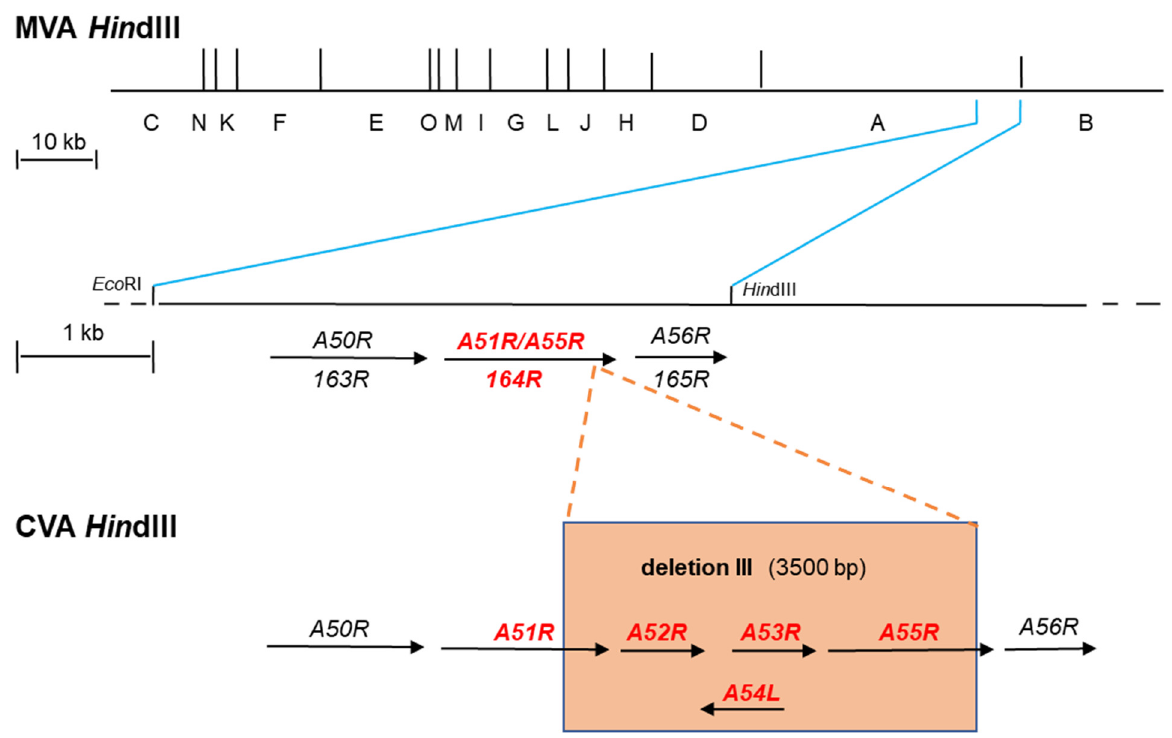
Figure 1. Illustration of the MVA genome and comparison of two distinct gene nomenclature systems which are currently applied. The VACV strain Copenhagen nomenclature relies on digestion of the viral genome using the restriction enzyme Hi ndIII. In the resulting Hind III map, the fragments obtained are alphabetically labeled from A to O. The largest fragment is named A and the smallest as O. Since the genome is bidirectional, genes are labeled R (right) and L (left) to indicate the genomic orientation of ORFs. The Hind III map of the MVA genome is shown (MVA Hin dIII). During attenuation in cell culture, chorionallantios vaccinia virus Ankara (CVA) the parental strain of MVA, suffered amongst others six major deletions within its genome resulting in strain MVA. Deletion III is shown as an example (orange box) (CVA Hin dIII). This deletion is located at the right end of the viral genome. In MVA, the flanking regions of deletion III are depicted within a fragment obtained when the Hin dIII A fragment is cut with Eco RI. In strain Copenhagen and strain CVA this fragment harbors amongst others the genes A50R to A56R . In contrast, deletion III resulted in the loss of genes A52R to A54L , truncation of A51R , and fragmentation of A55R (orange box). The latter two genes are expressed as a fusion gene ( A51R/A55R ) of unknown function in MVA. Another more recent nomenclature is based on sequencing data of the full genome of MVA (177,923 bp) coding sequences are numbered according to their first appearance starting from the left to the right end of the genome. The first ORF present 5’ in the genome is termed 001 and labeled R or L to indicate the genomic orientation. A more detailed illustration of the MVA genomic part after the occurrence of deletion III is shown (MVA Hin dIII). The genomic sequence from 146,084 bp ( Eco RI) to 150,758 bp ( Hin dIII) corresponds to the part obtained after cutting the Hin dIII A fragment with Eco RI. According to this, the nomenclature neighboring genes are hierarchically labeled including the gene 164R which corresponds to the A51R/A55R fusion gene in the Copenhagen